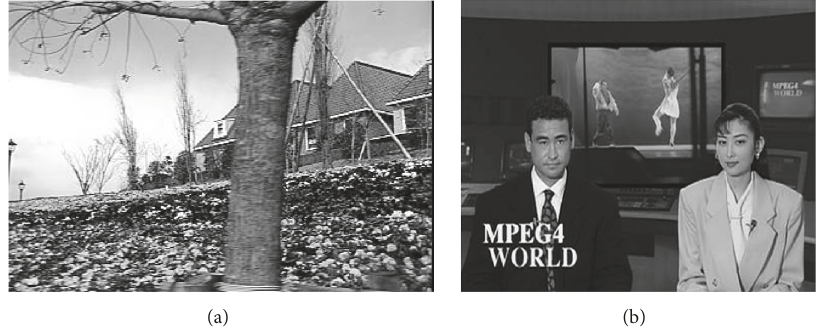
Figure 1: Two samples used in the experiments ((a) sample for flower , (b) sample for news ).